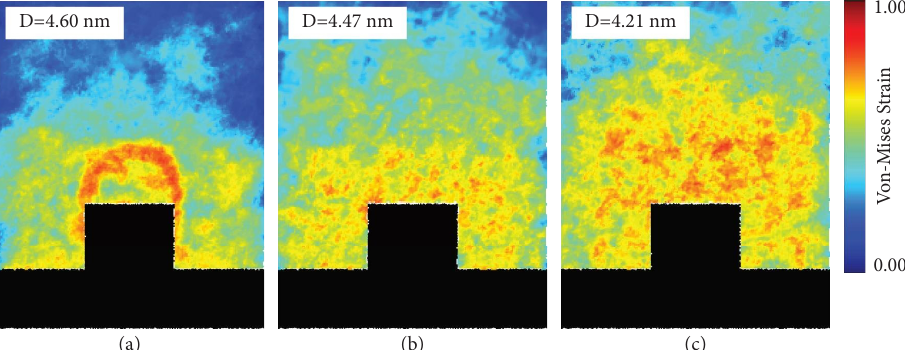
Figure 3: Imprinting process with tip-like pattern in the complete flling stage at (a) 300K, (b) 500K, and (c)